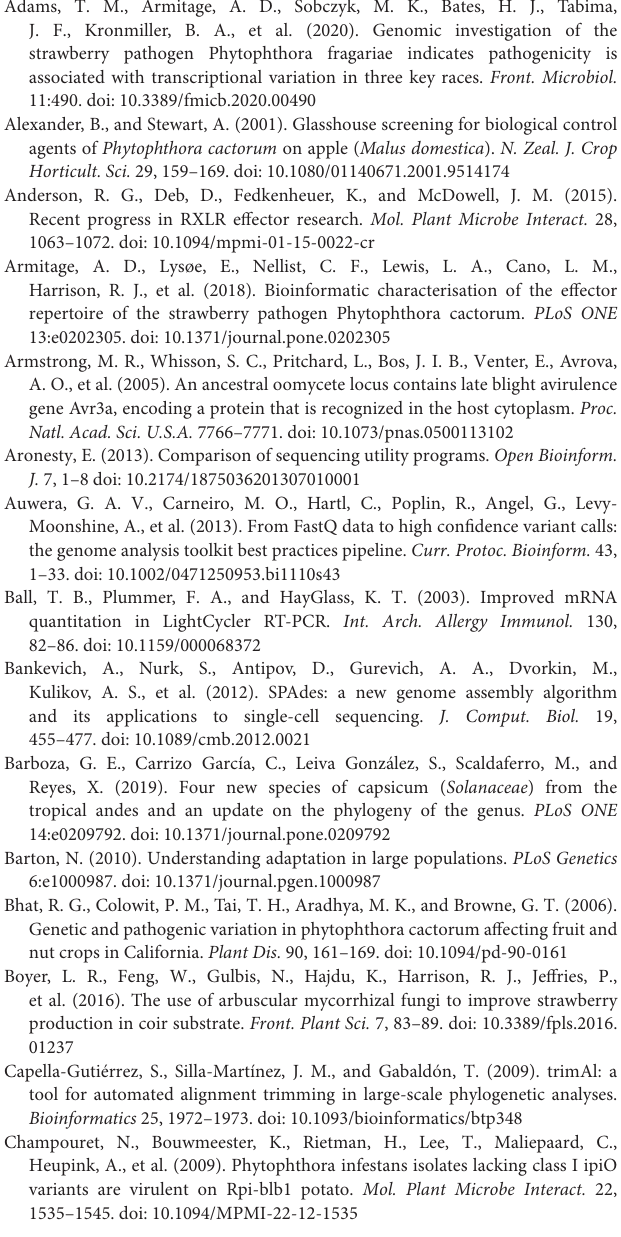
‘Elsanta’ fruit after artificial inoculation Phytophthora cactorum and Phytophthora idaei zoospores, from three separate experiments. Supplementary Figure 3 | Agarose gel electrophoresis of RT-PCR β -tubulin reactions on representative samples from inoculation time course experiment of Phytophthora cactorum isolate P414 on the ‘Emily’ cultivar of Fragaria × ananassa . L: 100 bp DNA Ladder (New England Biolabs). 1: Mock inoculated ‘Emily.’ 2: 6h post inoculation (hpi). 3: 12 hpi. 4: 24 hpi. 5: 48 hpi. 6: 72 hpi. 7: 96 hpi. 8: 120 hpi. 9: gDNA from ‘Emily’ (negative control). 10: gDNA from P414 mycelium (positive control). 11: dH 2 O (negative control). Supplementary Table 1 | Characteristics of primers used in this study.